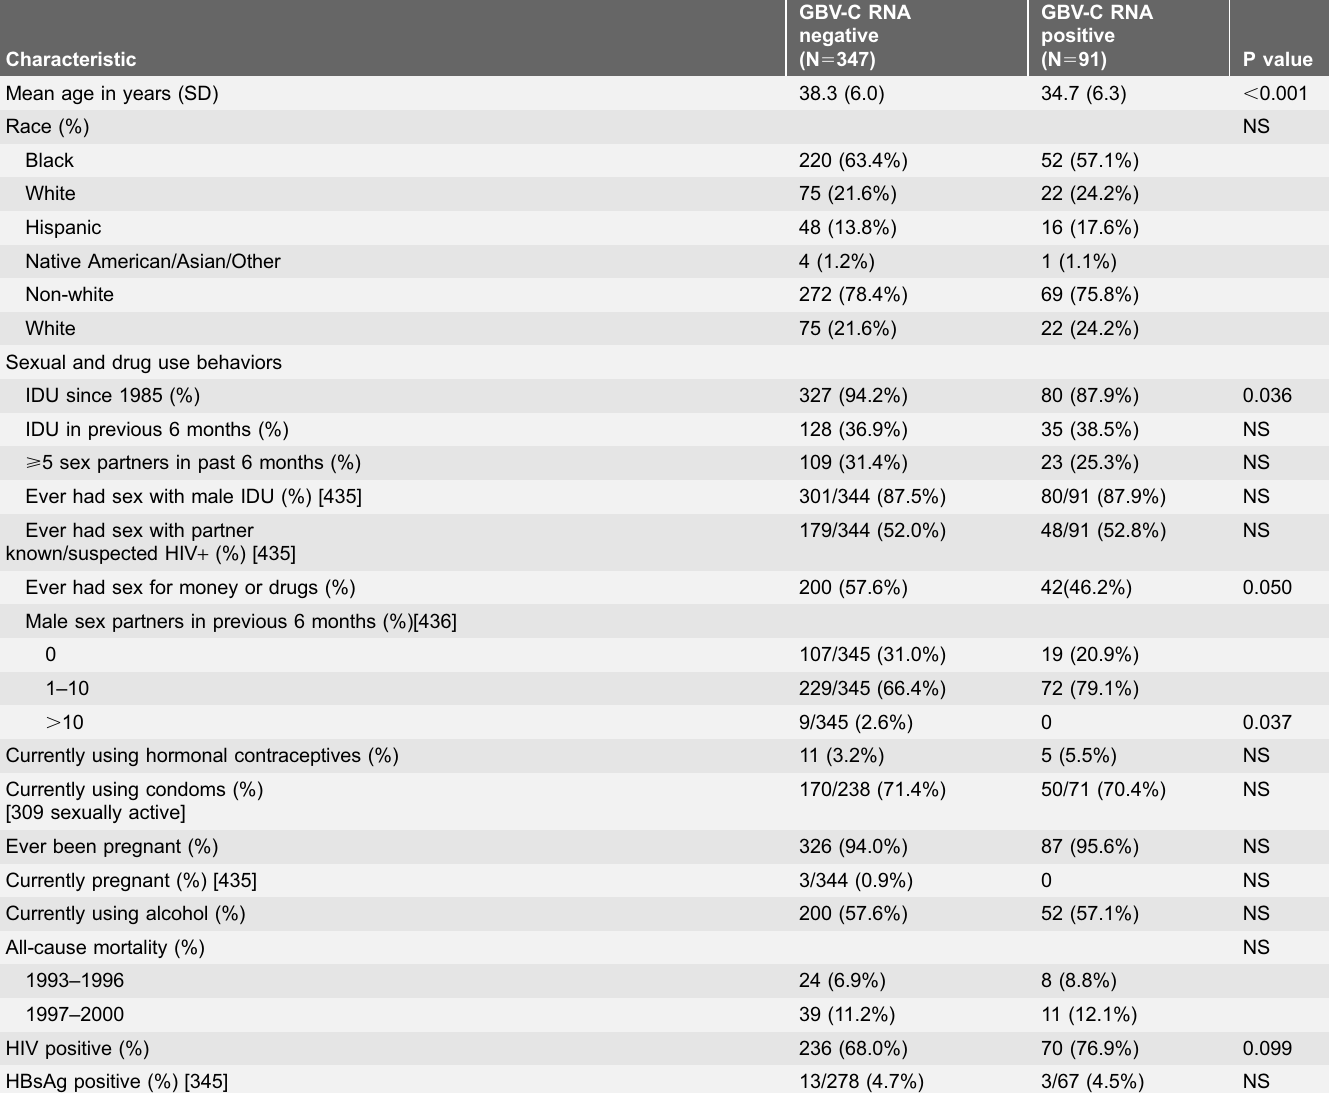
Table 1. Demographic and clinical data for 438 women from the HERS cohort included in the current study.